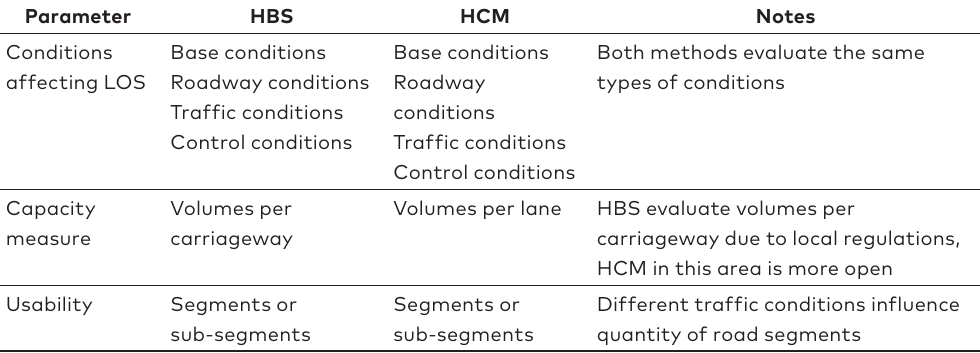
Table 3. Comparison of HBS and HCM methods in